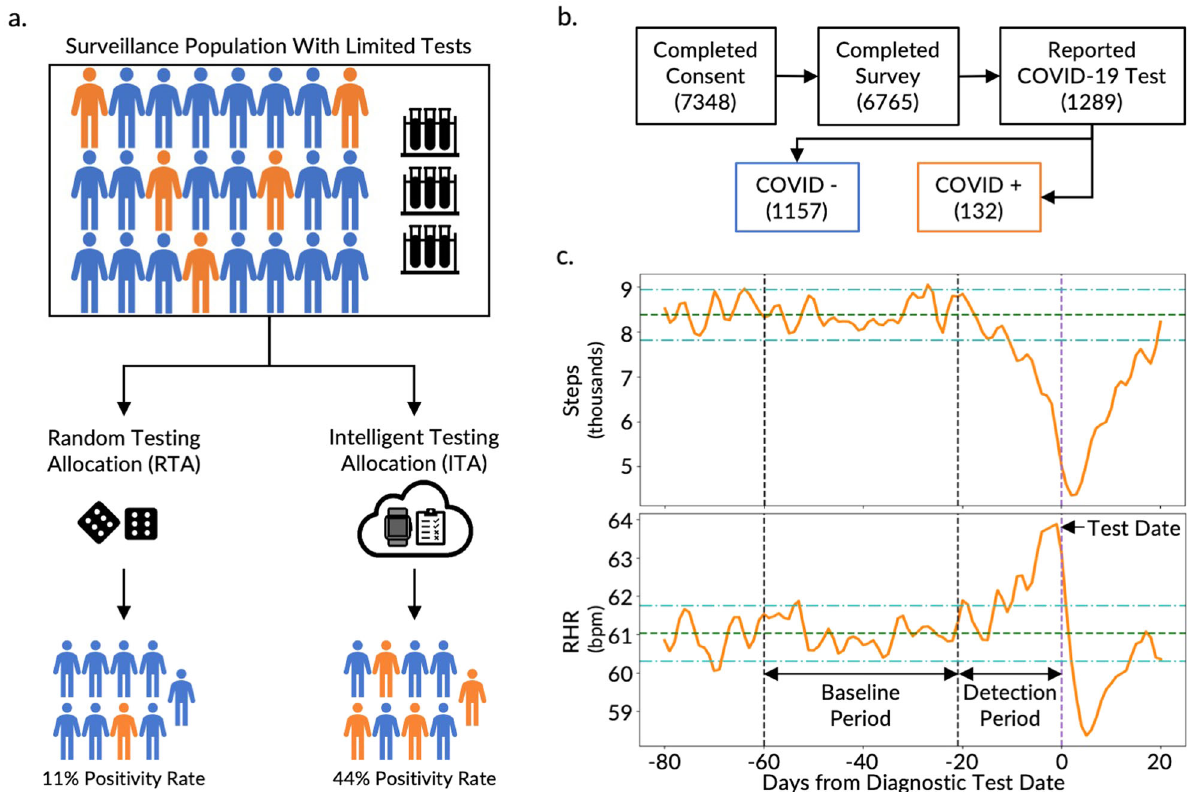
Fig. 1 Overview of the Intelligent Testing Allocation (ITA) model, the CovIdentify cohort, and data. a Overview of the ITA model in comparison to a Random Testing Allocation (RTA) model that demonstrates the bene fi t of using the ITA model over existing RTA methods to improve the positivity rate of diagnostic testing in resource-limited settings. Human symbols with orange and blue colors represent individuals with and without COVID-19 infection, respectively. b A total of 7348 participants were recruited following informed consent in the CovIdentify study, out of whom 1289 participants reported COVID-19 diagnostic tests (1157 diagnosed as negative for COVID-19 and 132 diagnosed as positive for COVID-19). c The top panel shows the time-averaged step count and the bottom panel shows the time-averaged resting heart rate (RHR) of all participants ( n = 50) in the training set (Supplementary Fig. 3, blue) who were tested positive for COVID-19 with the pre-de fi ned baseline (between – 60 and – 22 days from the diagnostic test) and detection (between – 21 and – 1 days from the diagnostic test) periods marked with vertical black dashed lines. The dark green dashed lines and the light green dash-dotted lines display the baseline period mean and ± 2 standard deviations from the baseline mean, respectively. The light purple dashed vertical line shows the diagnostic test